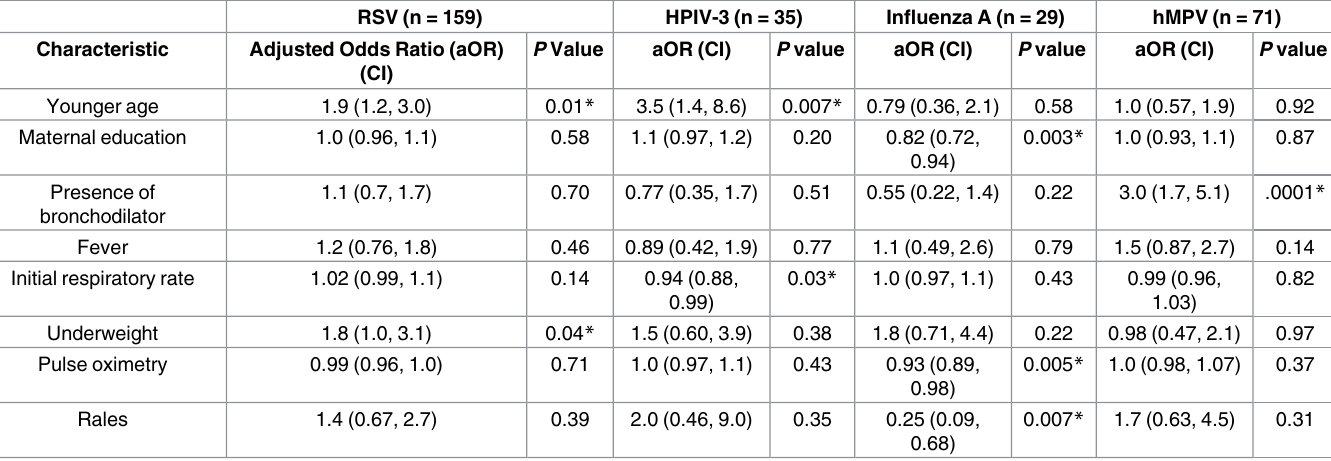
Table 3. Multivariable regression analysis of common pathogens by explanatory